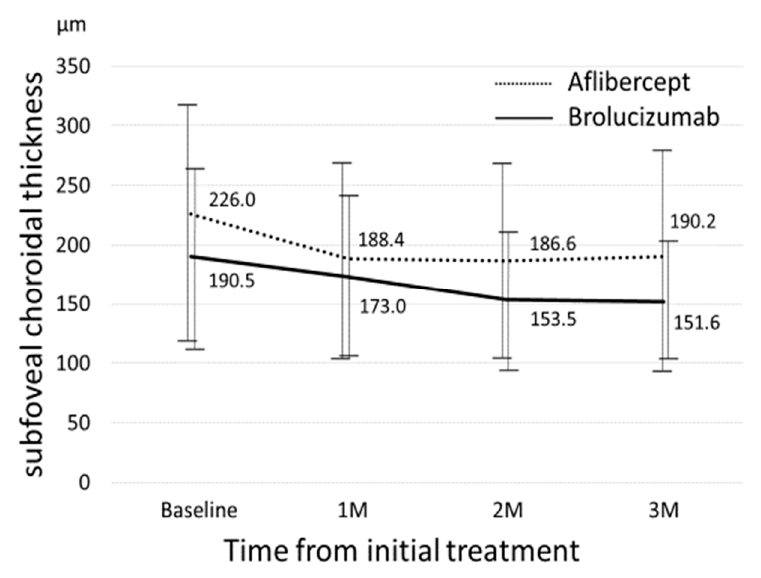
Figure 3. Changes in subfoveal choroidal thickness between the brolucizumab-treated and aflibercept- treated groups.